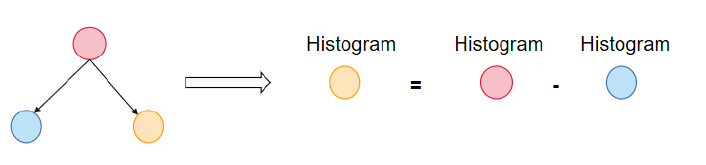
Figure 3. Acceleration of histogram differences. The red node presents the parent node; the blue node represents the left child node; the yellow node represents the right child